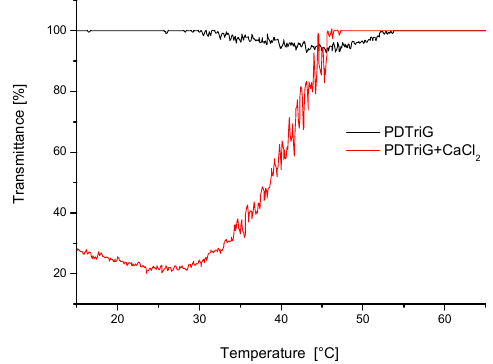
Figure 7. Transmittance as a function of temperature for PDTriG (black) and PDTriG with CaCl 2 (red) at pH = 10 (0.5 mg/mL) measured at a wavelength of 600 nm. at pH = 10 (0.5 mg/mL) measured at a wavelength of 600